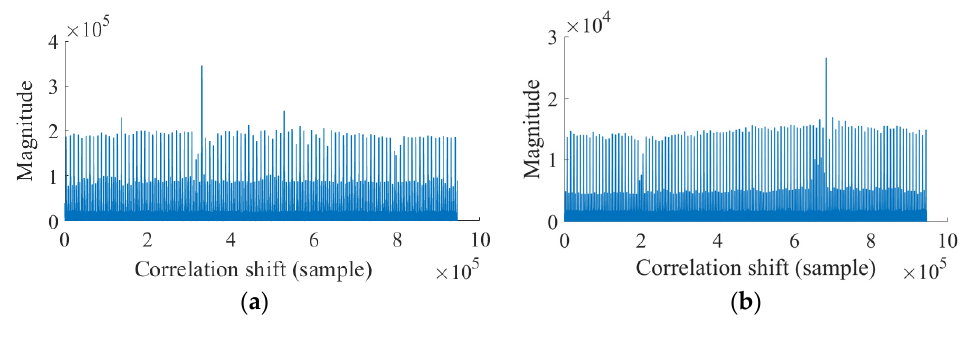
Figure 6. Acquisition results in static tests. ( a ) channel 26. ( b ) channel 48.